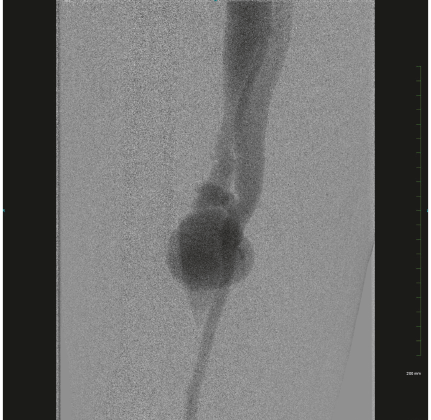
Figure 3: Right lower extremity angiogram showing a patent and enlarged right superficial femoral artery with a distal AV fistula connecting the superficial femoral artery to the femoral vein with venous flow upwards.